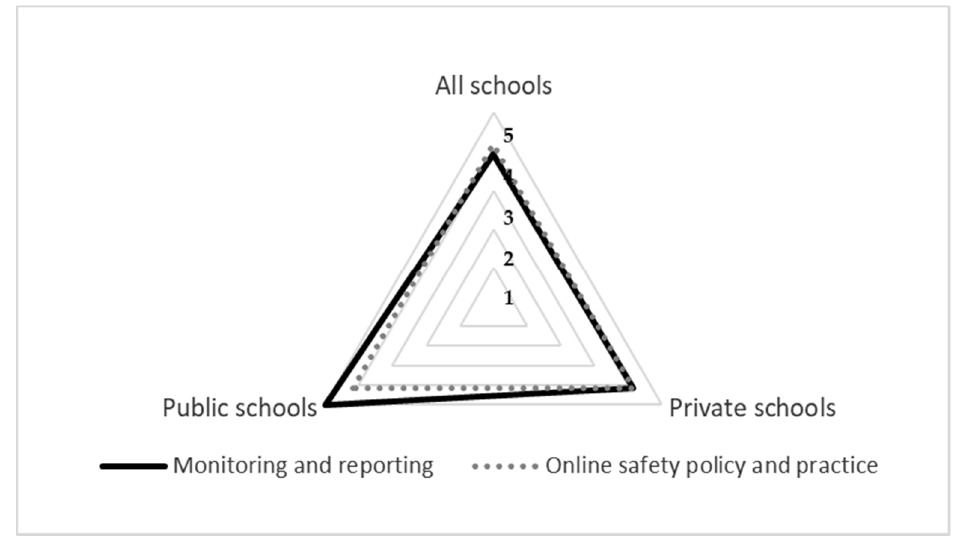
Figure 4. Strand 1 of Element D.